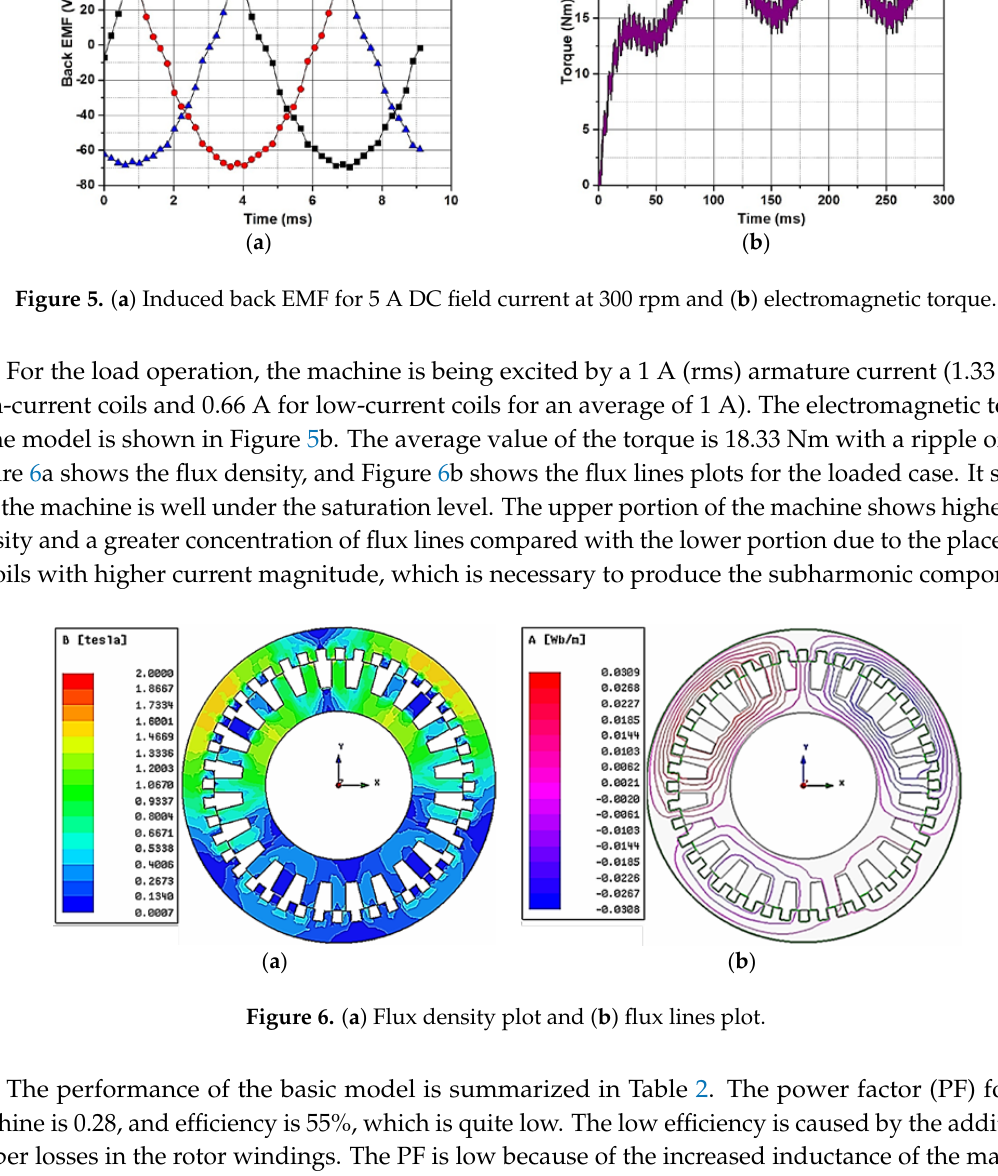
Table 2. Performance of the basic model of the BL-WRVM. Figure 6. ( a ) Flux density plot and ( b ) flux lines plot. Figure 6. ( a ) Flux density plot and ( b ) flux lines plot.